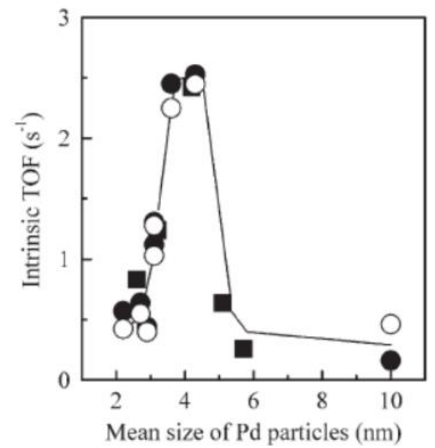
Figure 2. Dependence of the intrinsic turnover frequency on the mean size of Pd particles. The catalysts were reduced either by hexanol (full square) or H 2 . In the case of H 2 , the TOF was either based on Pd dispersion estimated by mean size of Pd (full circle) or based on Pd dispersion evaluated by CO chemisorption (empty circles). Reprinted with permission from ref. [34]. Copyright 2008, with permission from Wiley.